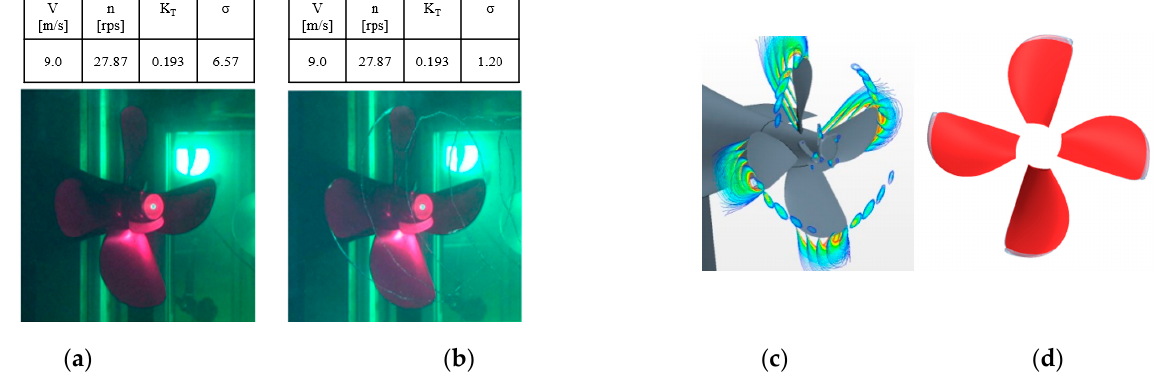
Figure 2. Experimental observation in non-cavitating ( a ) and cavitating flow ( b ) with flow simulation results: ( c ) Q-criterion contour, ( d ) iso-surface of Q-criterion (grey) on the blade (red).